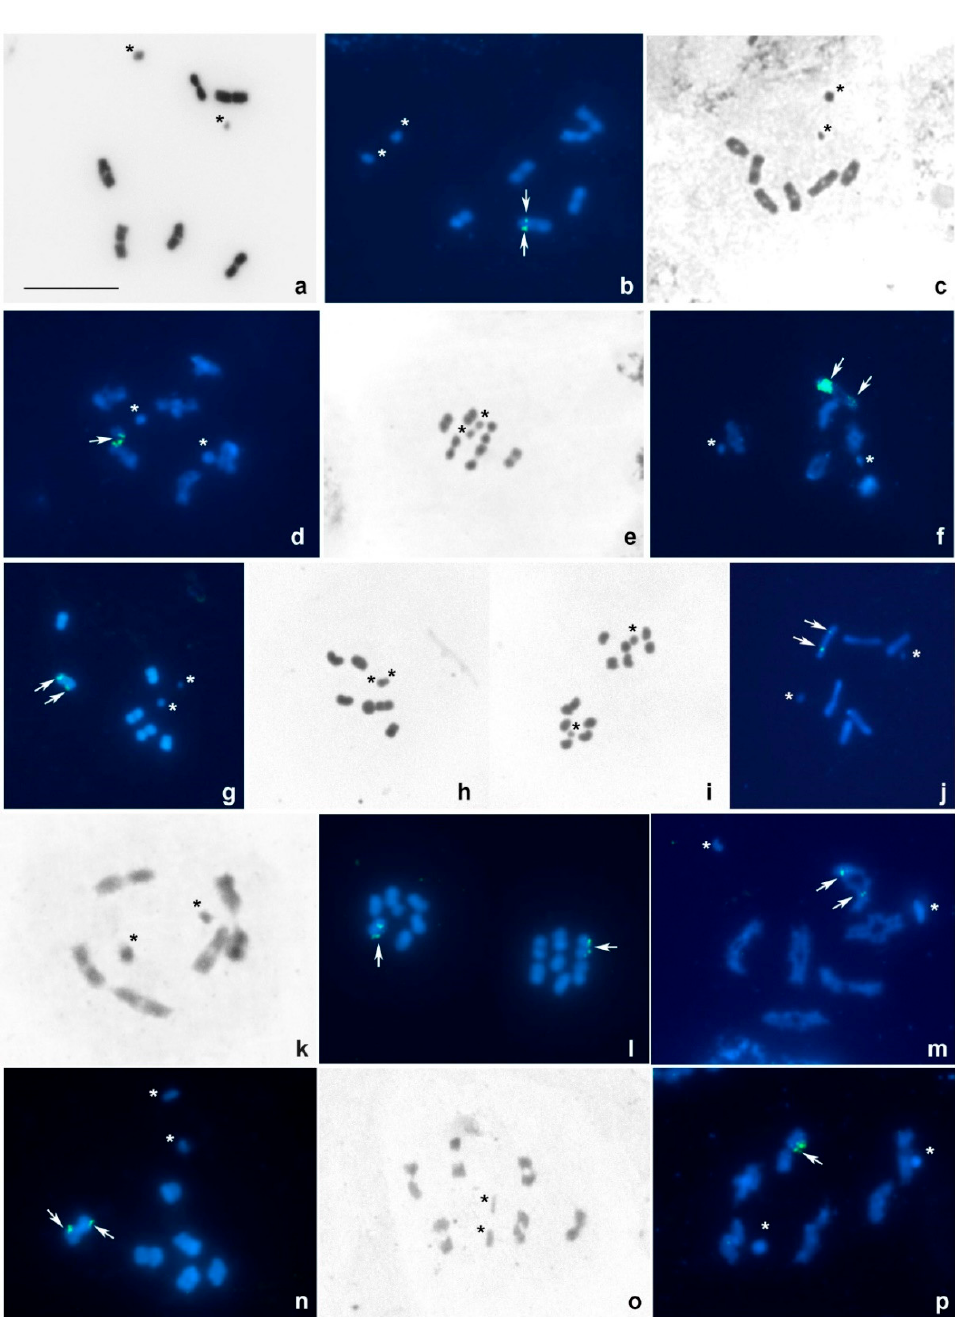
Figure 1. ( a – p ). Meiotic karyotypes of Tingini species after conventional staining and double FISH using 18S rDNA and telomeric TTAGG as probes. ( a ) Agramma blandulum , MI; ( b ) Agramma minutum , MI; ( c ) Copium adumbratum , MI; ( d , e ) Copium brevicorne, MI ( d ), diakinesis ( e ); ( f ) Copium clavicorne , diakinesis; ( g – i ) Corythucha arcuata, MI ( g , h ), MII ( i ); ( j ) Corythucha ciliata, MI; ( k , l ) Galeatus affinis, MI ( k ), MII ( l ); ( m ) Physatocheila putshkovi , diakinesis; ( n ) Physatocheila smreczynskii , MI; ( o ) Stephanitis oschanini , MI; ( p ) Tingis brevicornis, early metaphase I. Sex chromosomes are marked by asterisks; 18S rDNA signals are shown by arrows; TTAGG signals are absent. Bar = 10 mkm. Physatocheila putshkovi and Ph. smreczynskii , 2n = 14, XY (Figure 1m,n). In males of both species, six bivalents of autosomes and two sex chromosome univa- lents, X and Y, were observed at different stages of the first meiosis, including diakinesis and MI (Figure 1m,n) assuming they have 2n = 14 and an XY sex determination system